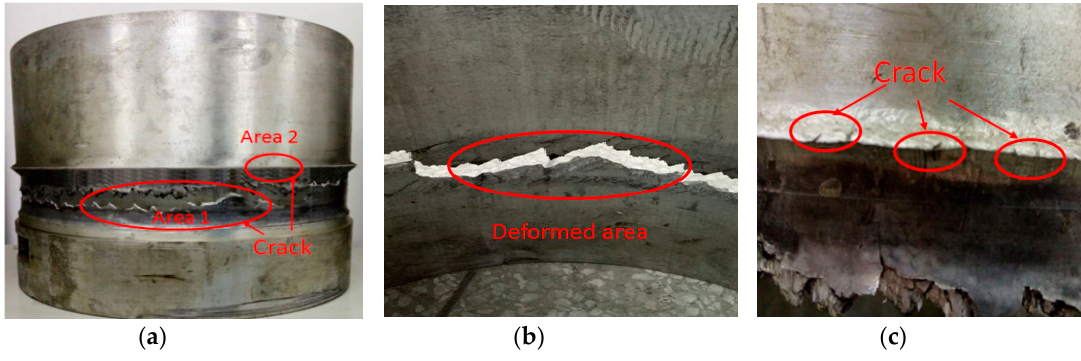
Figure 8. Crack defects of tube in experiment in the ( a ) outer surface; ( b ) inner surface and ( c ) magnified image of Area 2 in the outer surface of tube at wall thickness reduction ratio of 50%.